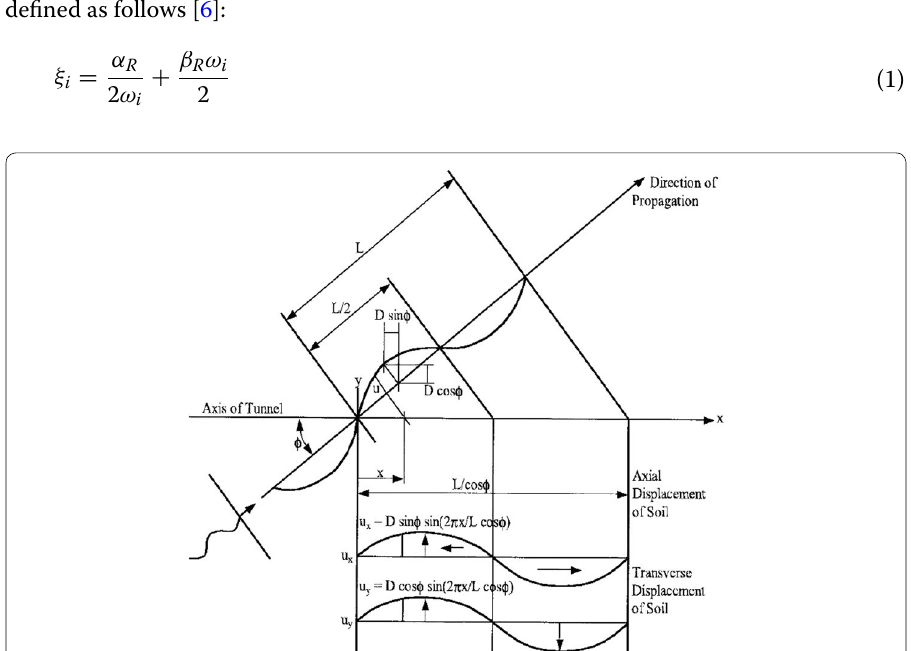
Fig. 1 Simple harmonic wave and tunnel